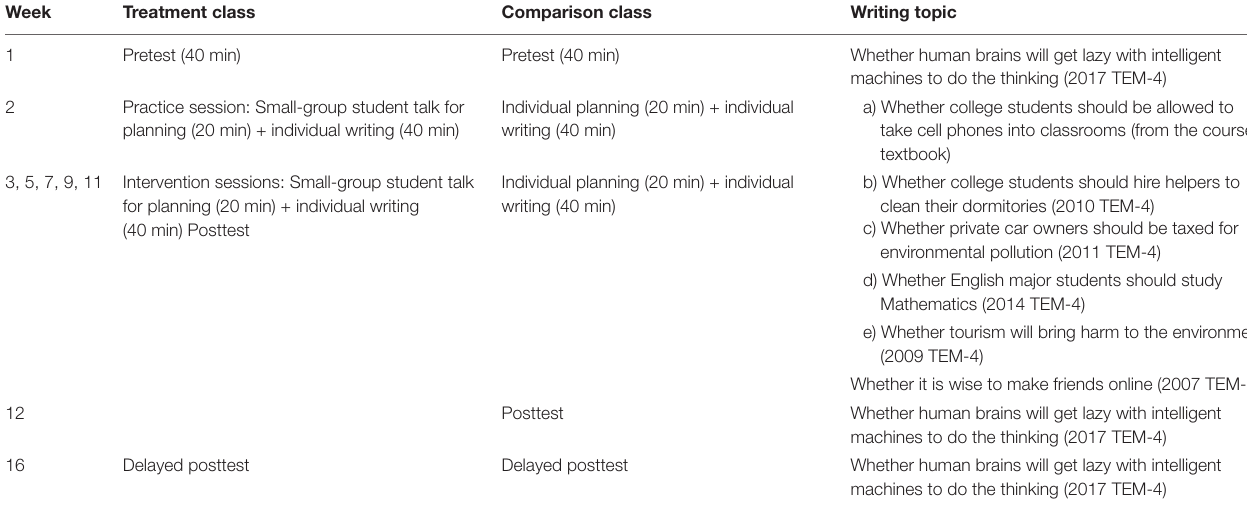
TABLE 1 | Procedures of the